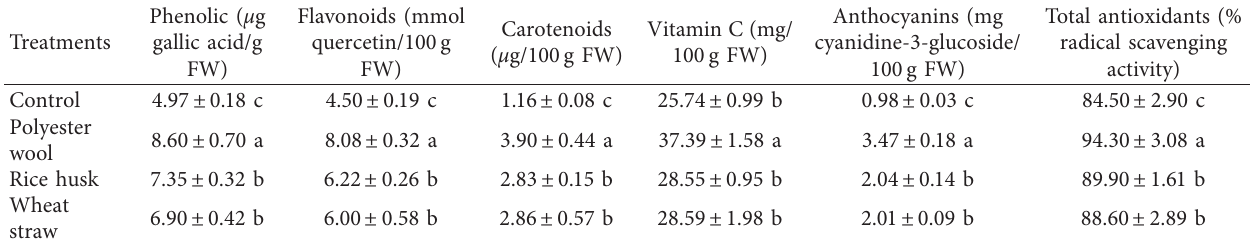
Table 5: Effect of different growth substrates on health-related compounds of strawberry cv. Chandler.